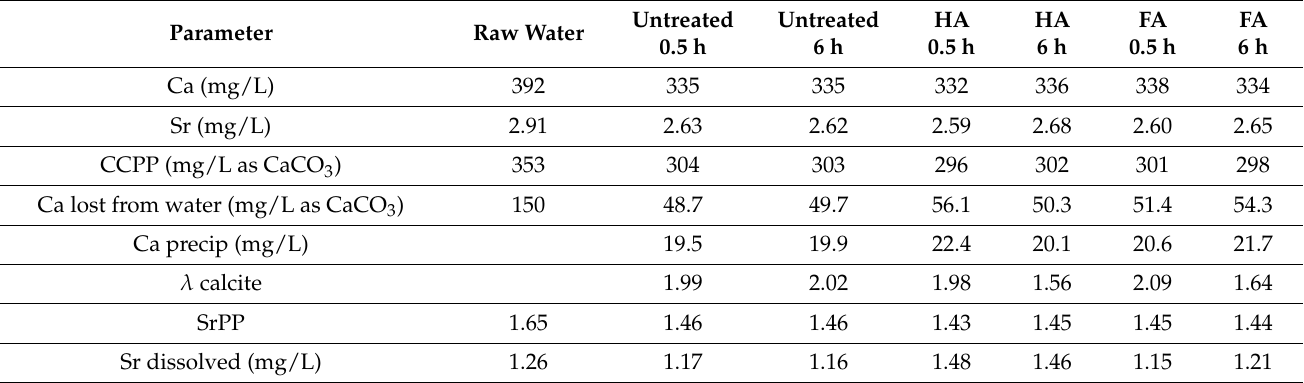
Table 2. Summary of calcium and strontium concentrations * and precipitation potential (CCPP and SrPP) in WTP wastewater samples and under experimental conditions exposed to pyrolusite